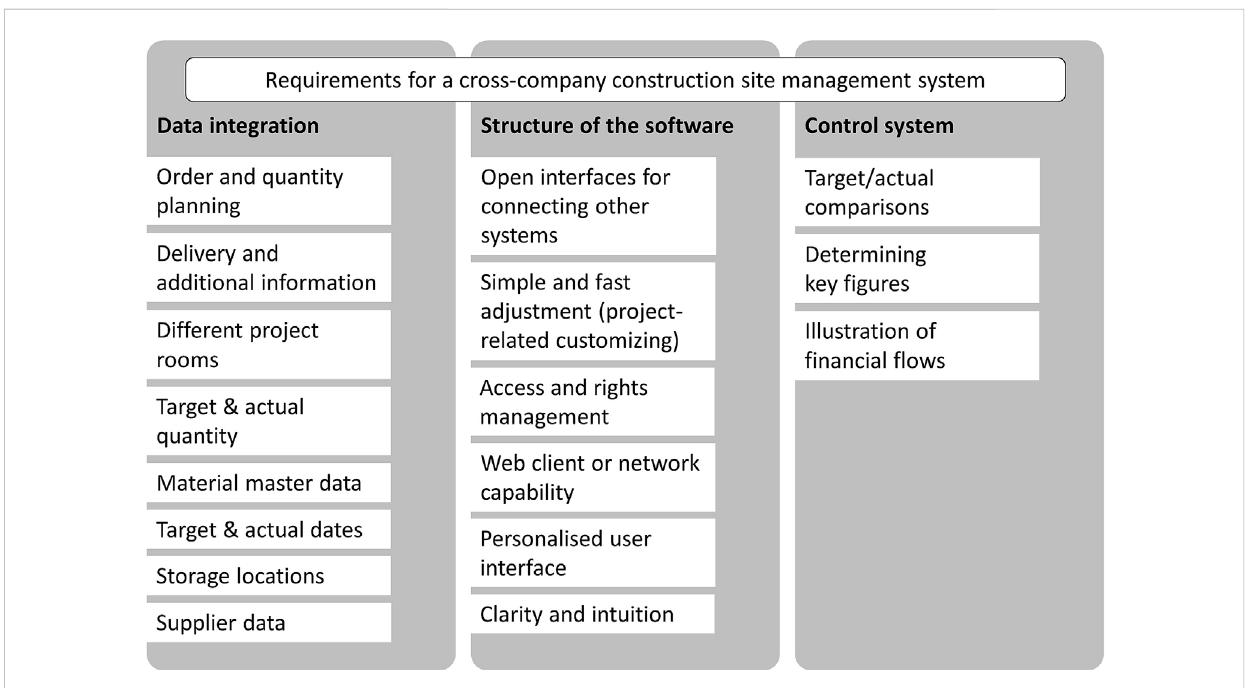
FIGURE 4 Requirement for a construction site management system (Hasenclever et al.,